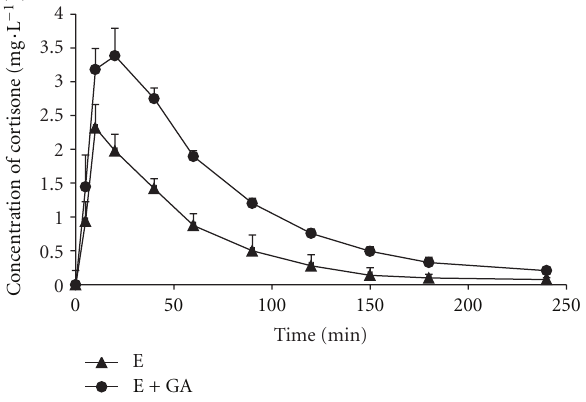
Figure 2: Mean concentration-time curve of cortisone in two groups n = 6.